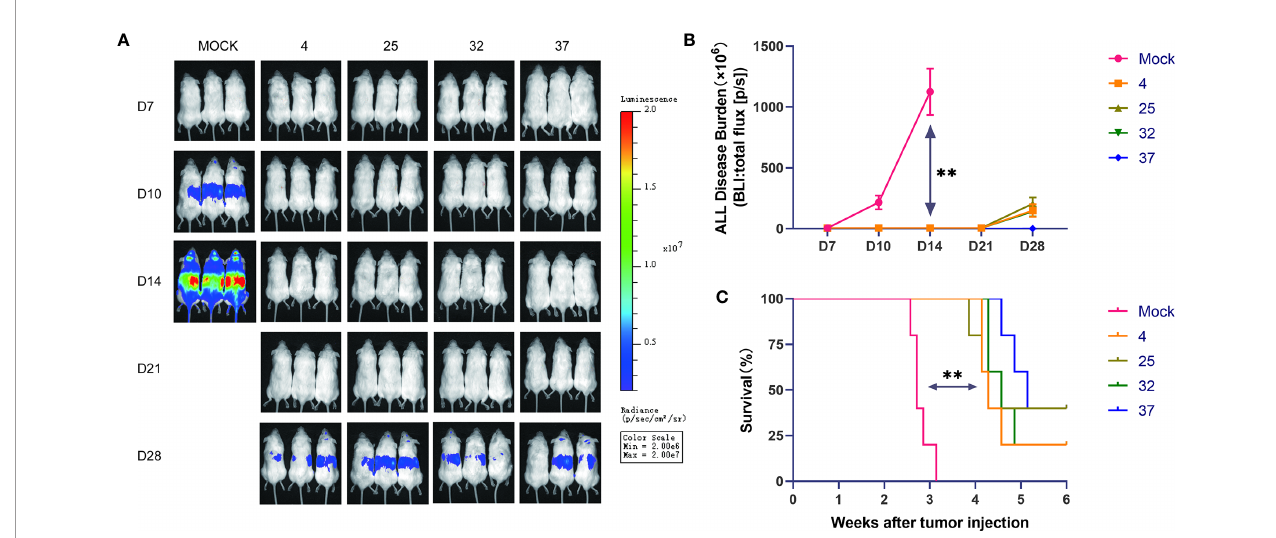
FIGURE 5 | Effect of infection temperature on CAR-T cells in a mouse tumor model (A) Mice were injected with luciferase-containing NALM-6 cells through the tail vein. On the third day, the prepared CAR-T cells were injected into the mice through the tail vein. The tumor load in the mice was detected by in vivo imaging technology on the 7th, 10th, 14th, 21st and 28th days. (n=5, each group gives a representative picture of 3 mice). (B) Quantitative graphs of tumor burden in each group of mice at different time points are shown. (C) Survival of mice injected with uninfected T cells or CD19 CAR-T cells generated at different infection temperatures. Mean ± SD. **p <